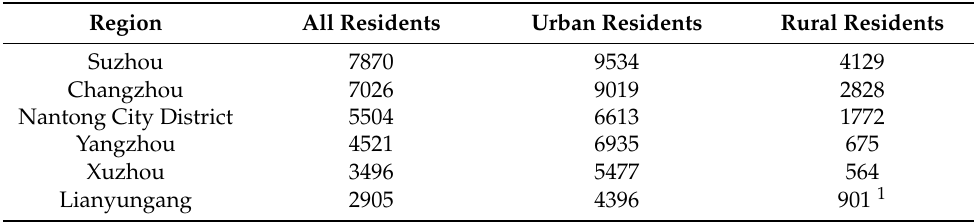
Table 6. Pension income levels per household in selected regions, 2018 (yuan).